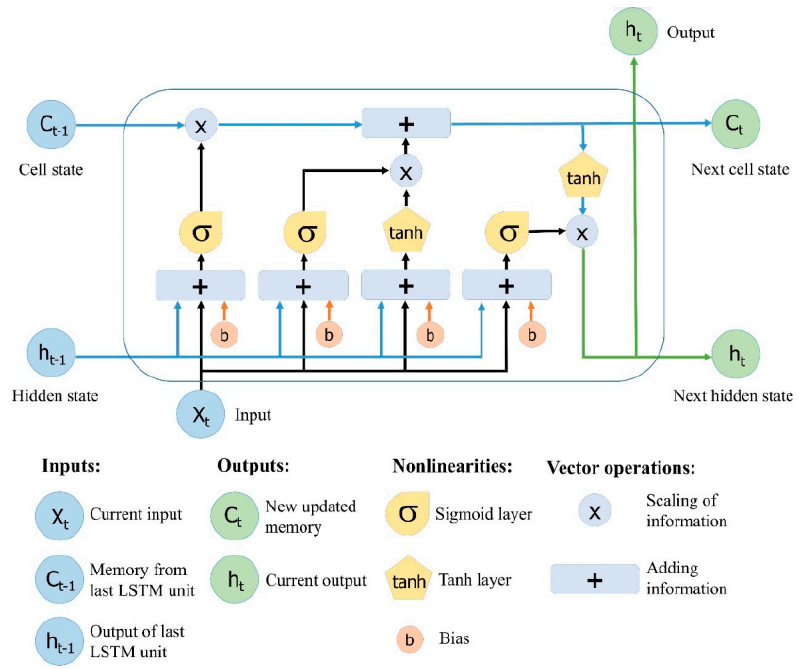
Figure 3. Internal structure of LSTM